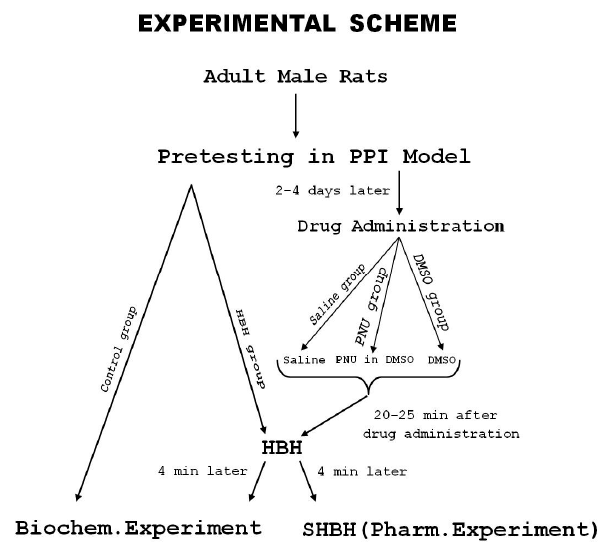
Figure 1. The scheme of the experiment. PPI, prepulse inhibition in acoustic startle reaction; HBH, moderate hypobaric hypoxia; SHBH, severe hypobaric hypoxia. PNU, nicotinic α 7 receptor agonist PNU-282987; DMSO, solvent dimethyl sulfoxide. Biochem. Experiment, biochemical experiment; Pharm. Experiment, pharmacological experiment. For the number of animals per group, see com- ments in the text of this subsection (Experimental protocol).